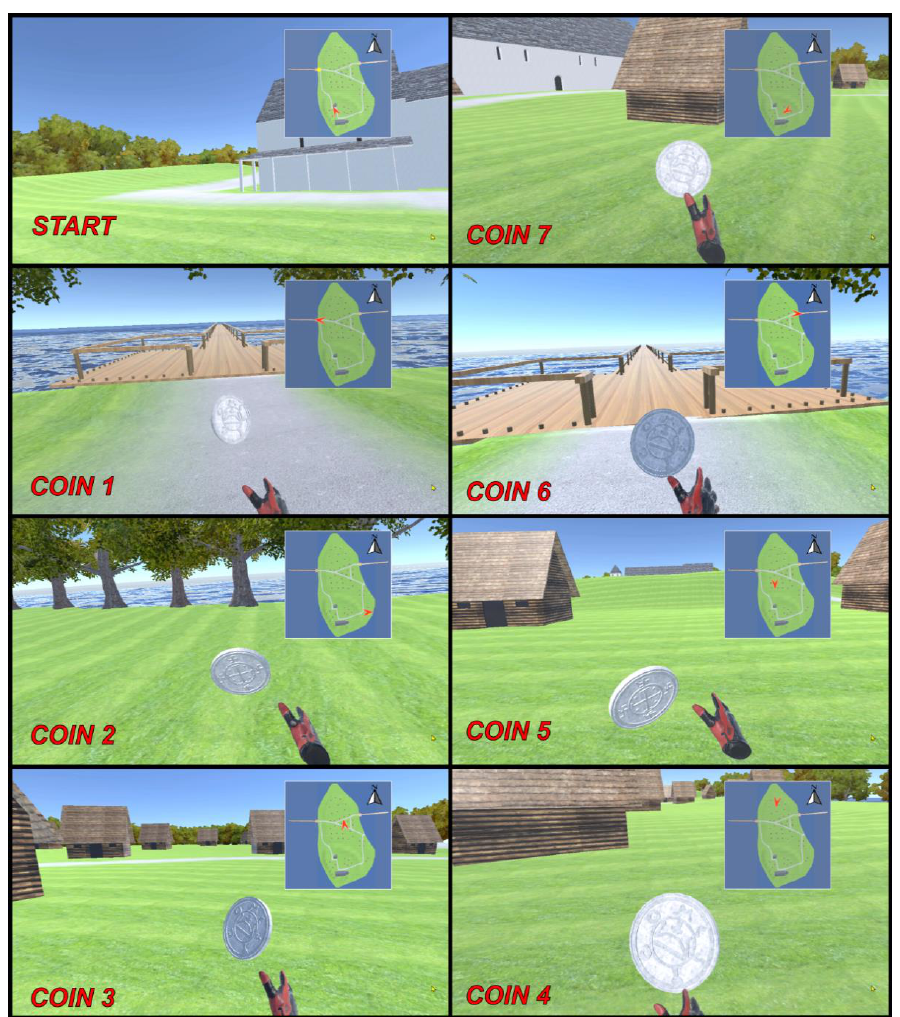
Figure 5. View in HTC Vive Pro Eye goggles during the collection of coins at the starting point and at each coin.